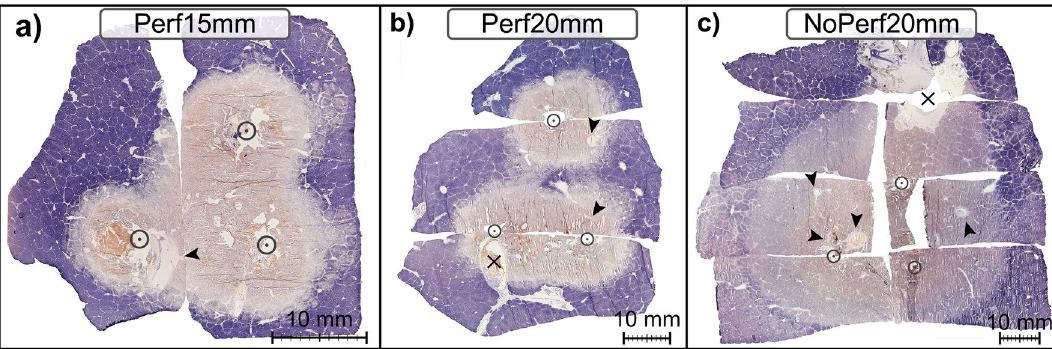
Figure 1. Exemplary display of histological ablation shapes (NADH staining) for each ablation setting with an applicator distance of 15 mm ( a ), 20 mm ( b ) and 20 mm with Pringle maneuver ( c ). All vessels with a diameter ≥ 0.5 mm were analyzed in each histological slide. Vessel type, tissue vitality around each vessel and vessel localization were evaluated. Vessels situated at the border between ablation zones (X) were categorized to the zone which contained its largest areal proportion. (arrowhead = ablated vessels situated in the WZ; circle = applicator puncture represents the area where complete cell destruction occurs 18,19 . This zone merges into the so-called “red zone”